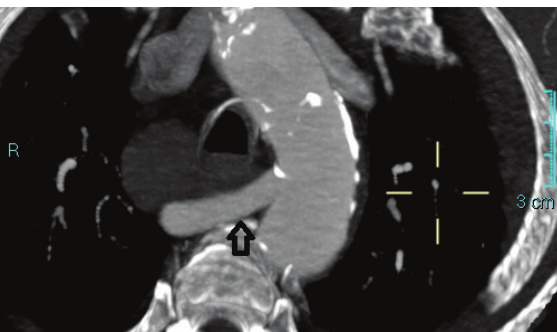
Figure 1: CT showing the anomaly of the right subclavian artery (arrow) with an evident retroesophageal course (also called lusory